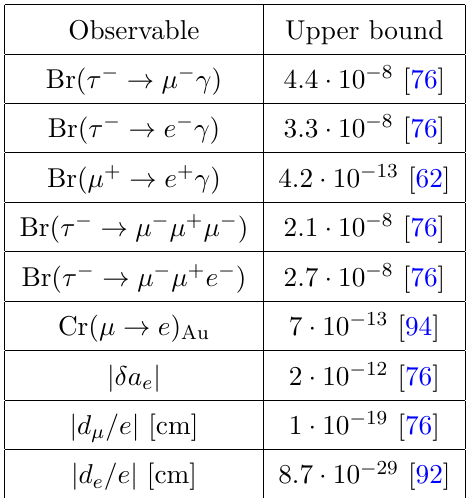
= (cid:1) m 2 > 0 for NO and (cid:1) m 2 = (cid:1) m 2 < 0 31 32 3 ‘ 3 ‘